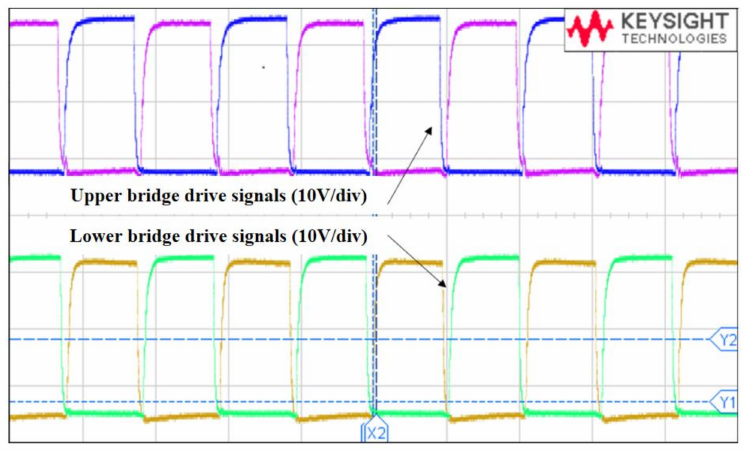
Figure 13. Drive